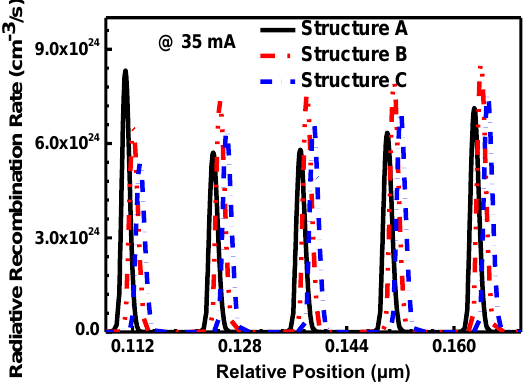
Figure 6. Radiative recombination rate in the MQWs for Structures A, B, and C, respectively. Data are collected at the injection current level of 35 mA.